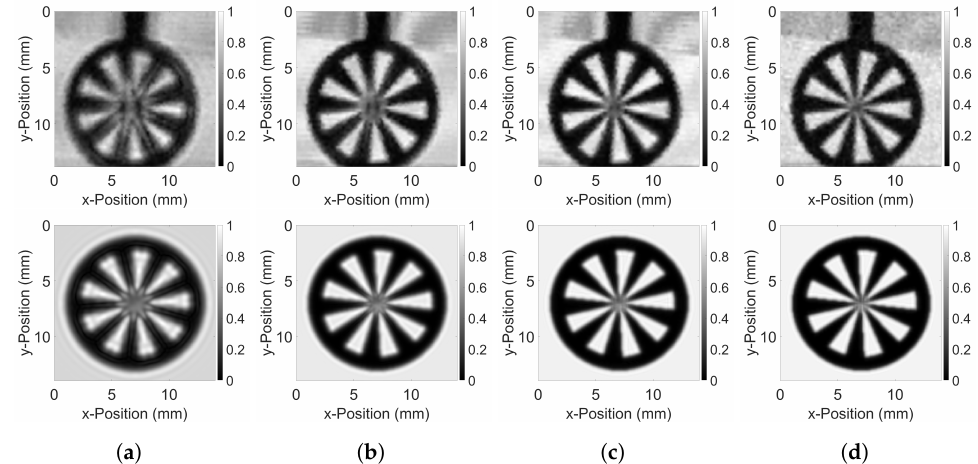
Figure 6. Resolution target images for selected frequencies taken with a 0.5 mm mask at a distance of 0.5 mm. Measurement (top row) and simulation (bottom row): ( a ) 0.5 THz; ( b ) 1.0 THz; ( c ) 1.5 THz; ( d ) 2.0 THz.